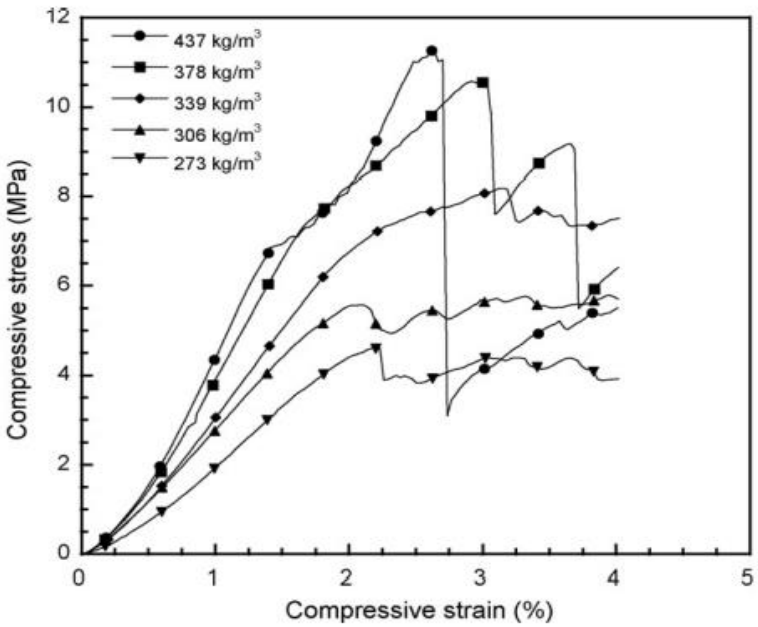
Figure 13. Compressive stress–strain curve of benzoxazine foam at varying densities (reproduced from the work in [59] with permission).